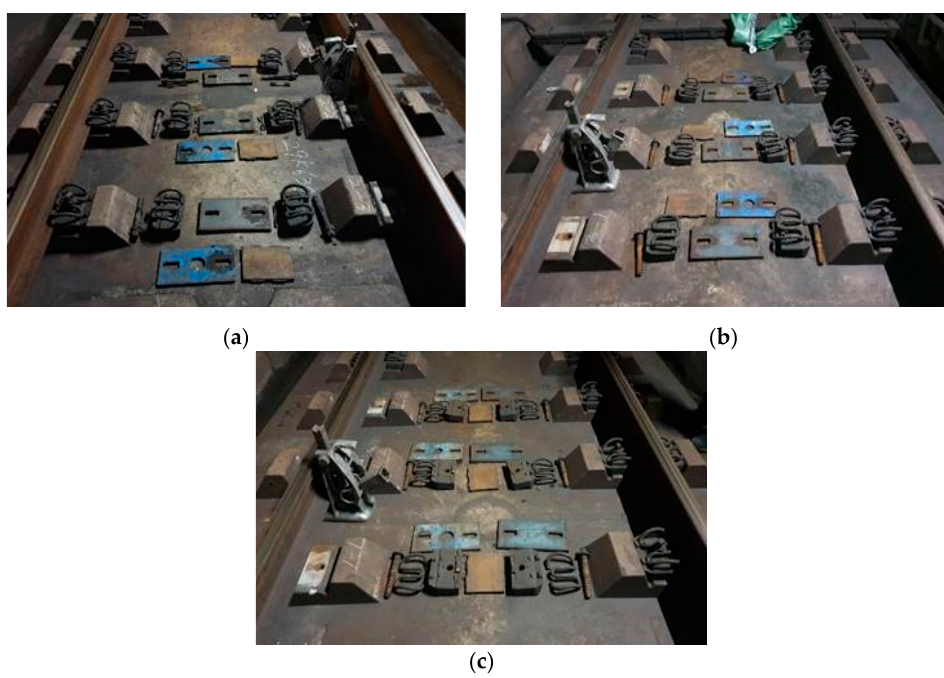
Figure 4. Collected specimens. Service period of ( a ) 6 years; ( b ) 11 years; ( c ) 16 years.